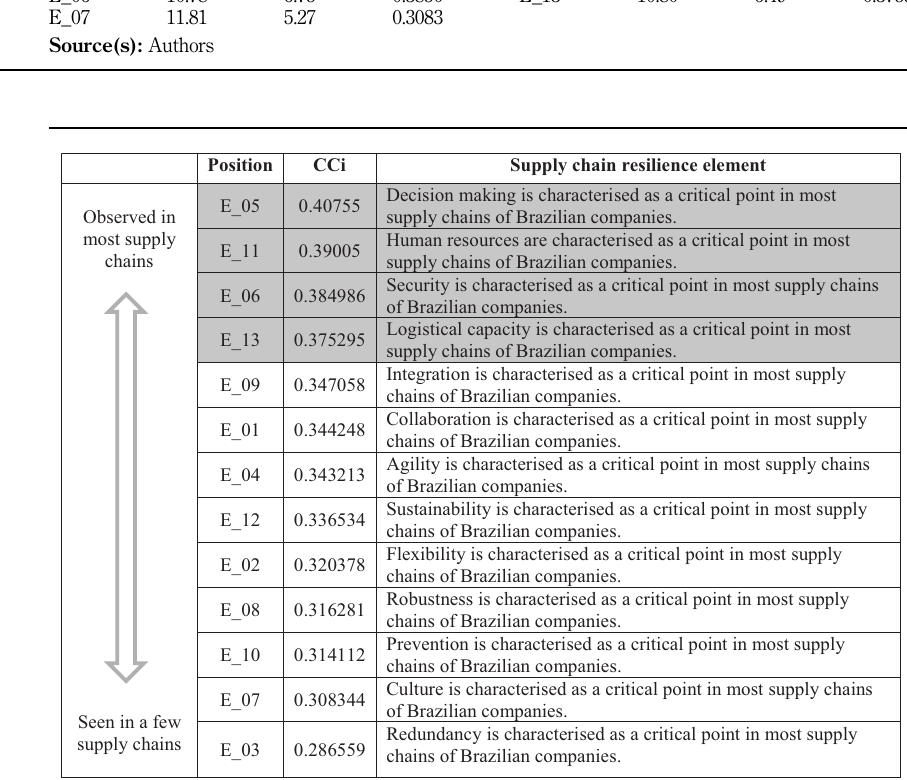
analysed resilience